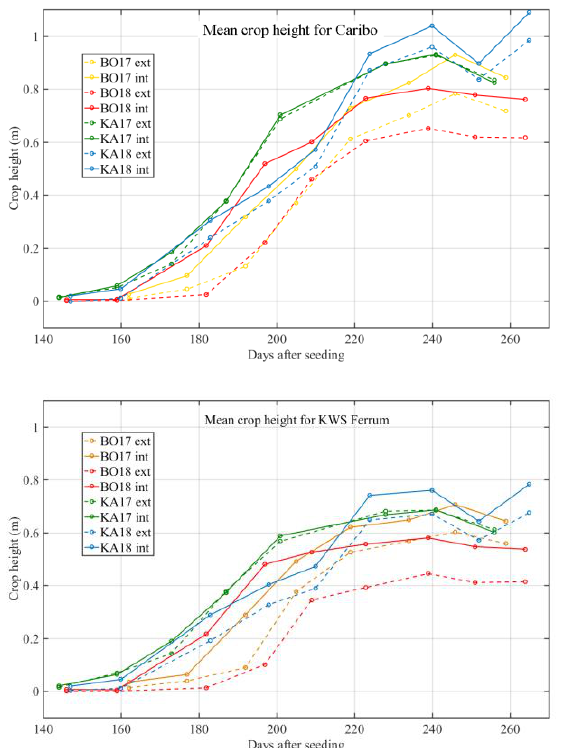
Figure 11. Seasonal crop height for two selected genotypes at different location, different systems and different growing season